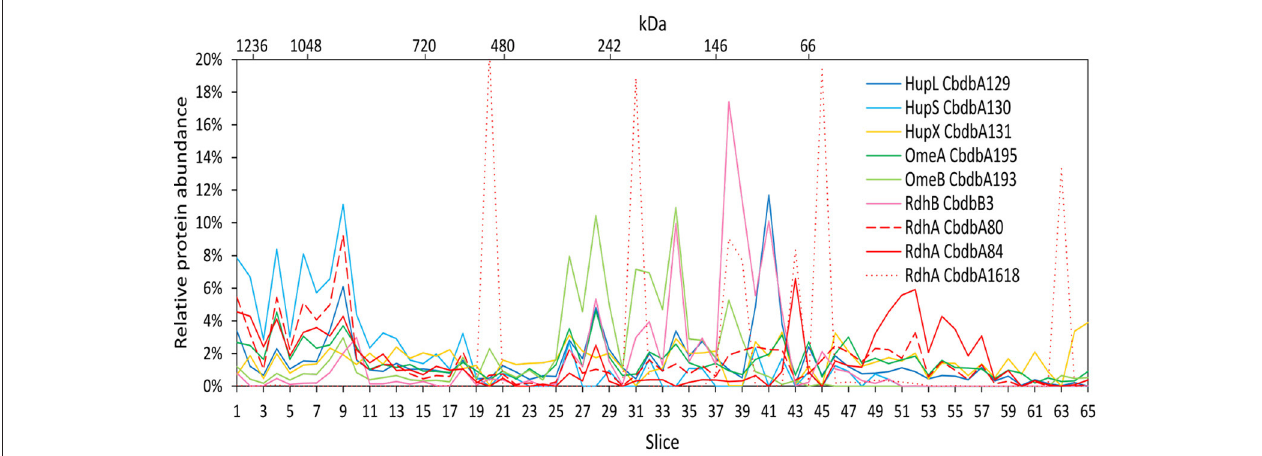
FIGURE 3 | Relative abundance of proteins associated with the OHR complex across the length of a blue native gel cut into 65 slices after membrane fraction DDM extraction (protein extraction mode 2). The color code is the same as used in Figure 1 . Different RdhA proteins are shown with different line types.